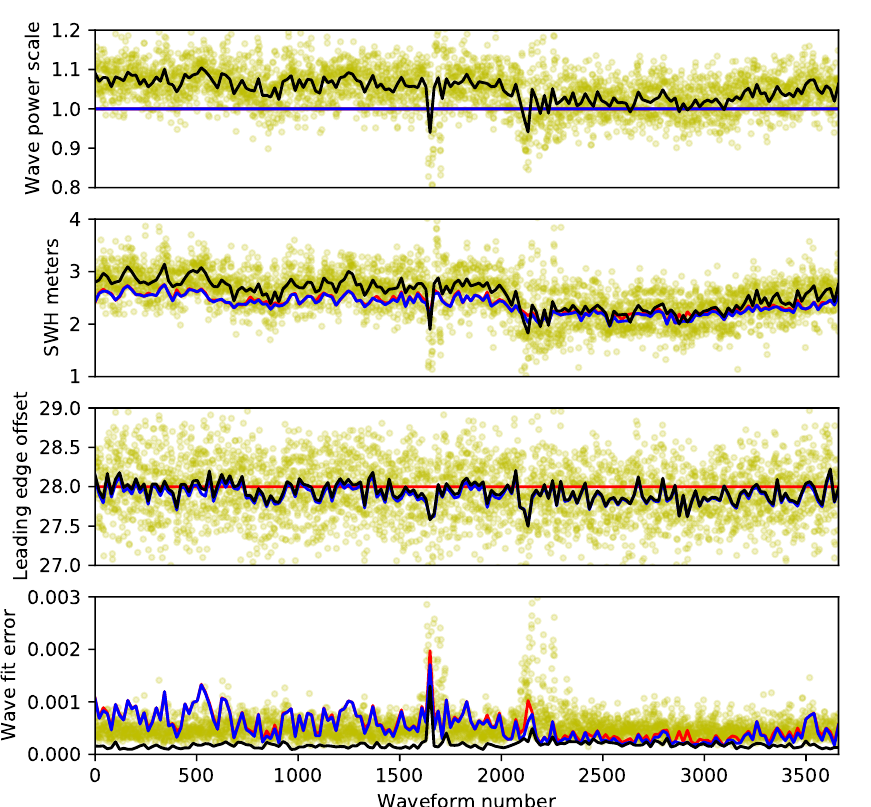
Figure 3. Comparison of the three methods of waveform fitting for 1 Hz downsampling over a section of satellite track in the North Atlantic. Red: fitting of σ s (SWH) only, blue: σ s and t 0 (waveform leading edge), black: σ s , t 0 and A (waveform power scale). These results are compared to a three parameter fit of each individual 20 Hz waveform (yellow scatter). Retrieved (or default values) of wave power scale, SWH and waveform leading edge are plotted, along with the fit error between the the original and optimal semi-analytical